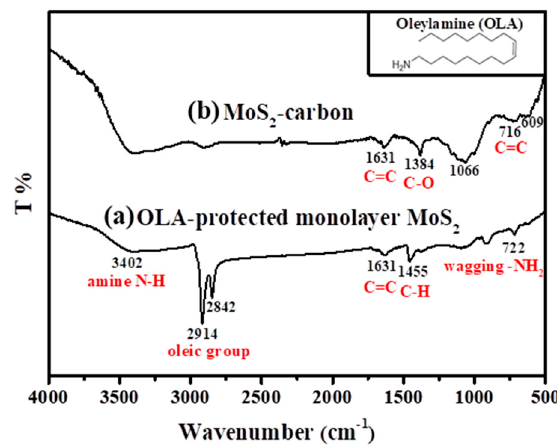
Figure 2. FT-IR spectra of ( a ) OLA-protected monolayer MoS 2 and ( b ) MoS 2 -carbon. Insert of the figure is the molecular structural formula of OLA.